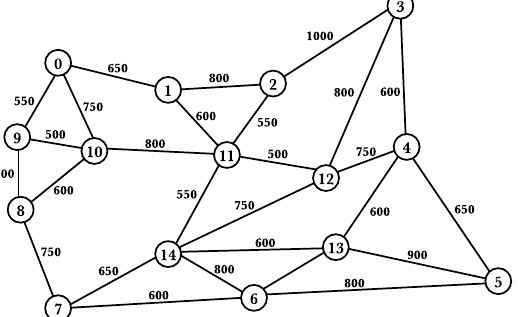
Figure 5. The CHNNET topology with 15 nodes and 27 fiber